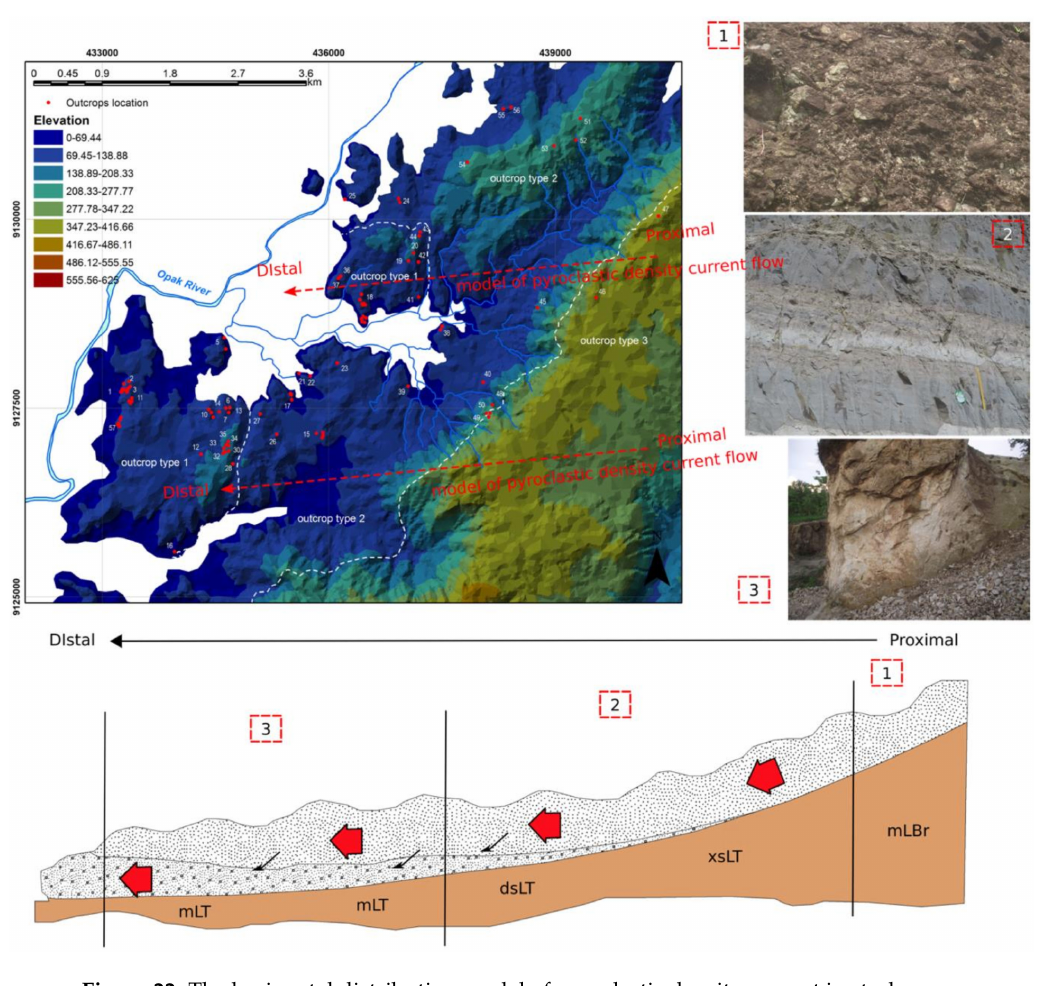
Figure 22. The horizontal distribution model of pyroclastic density current in study